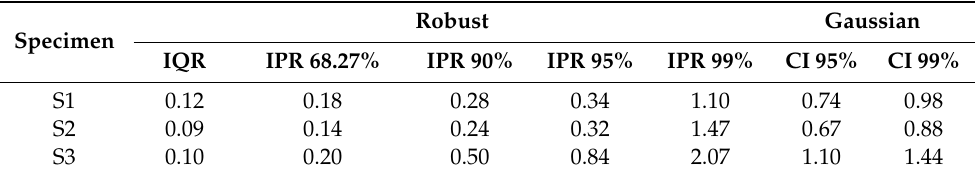
Table 9. Robust interpercentile ranges (IPR) and Gaussian confidence intervals (CI) for the macro / zoom lens comparison. Units: millimeters.